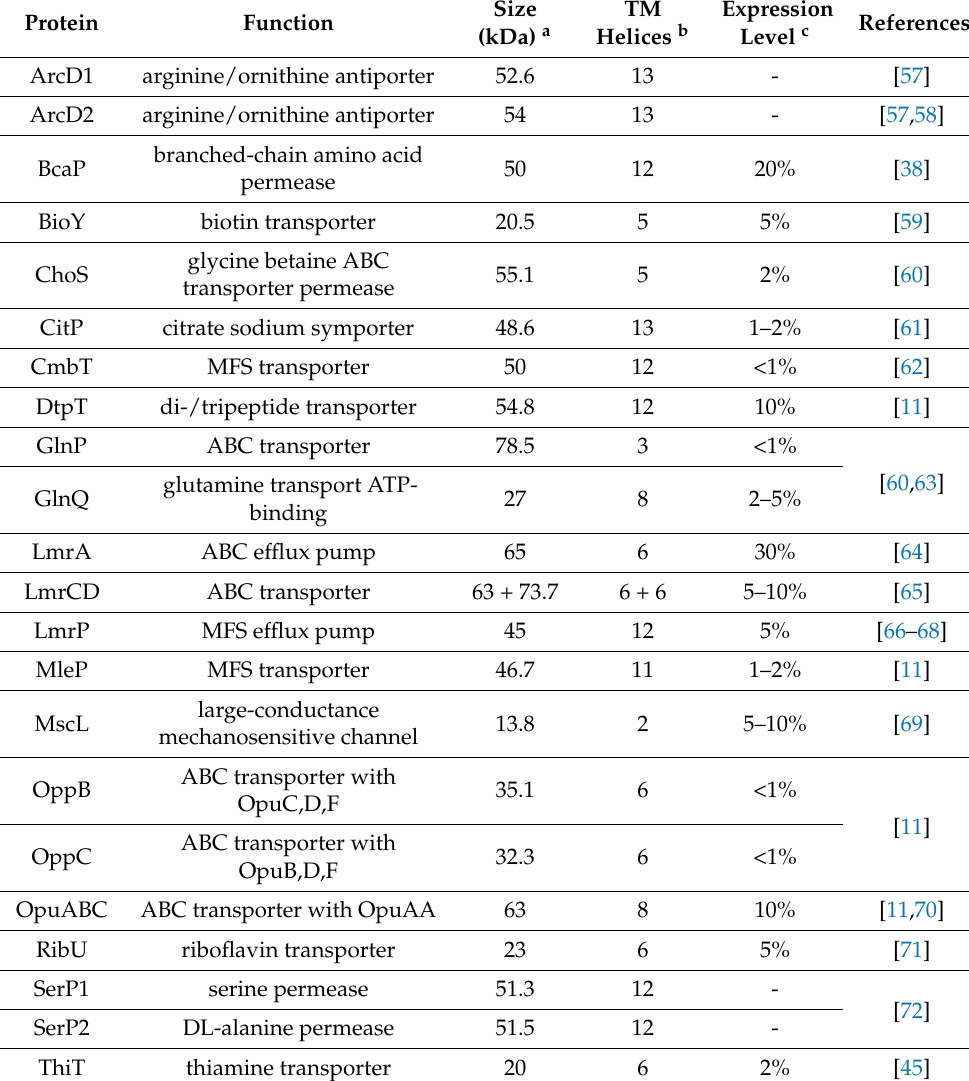
Table 2. List of homologous prokaryotic